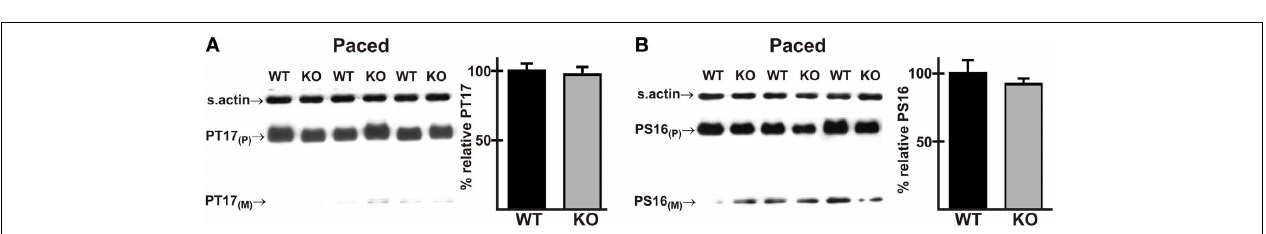
FIGURE 6 | Phosphorylation of phospholamban in wild-type and AE3-null hearts subjected to atrial pacing in vivo . WT and AE3-null (KO) mice were anesthetized, instrumented, and subjected to in vivo pacing as described in Figure 2 . Ventricular tissue was harvested during pacing at 550bpm, and immunoblot and densitometric analyses of homogenates were carried out to determine levels of (A) PLN